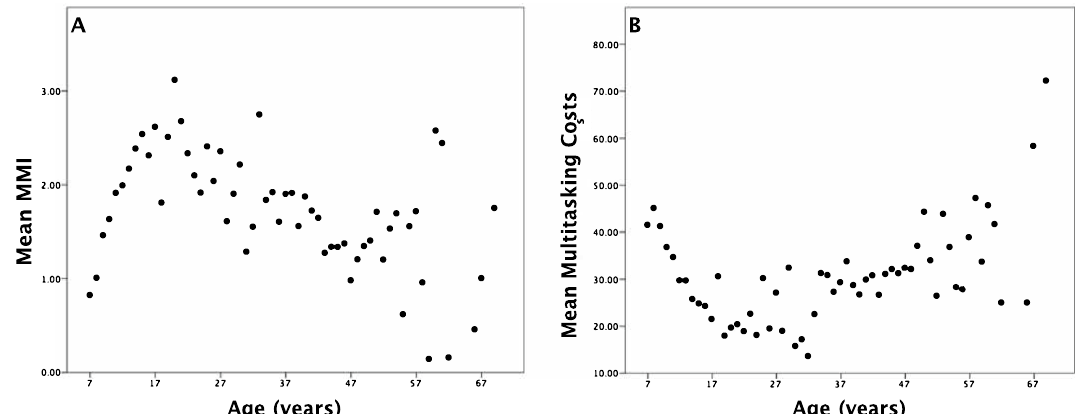
Figure 4. The relationship between age and indices of multitasking. ( A ) Mean MMI scores as a function of participant age. ( B ) Mean multitask cost as a function of participant (Δ F (1, 1507) = 90.674, p ≤ 0.001, R 2 change = 0.057). A quadratic function fit to the data indicated that the lowest their late 20 s to the early 30 s.